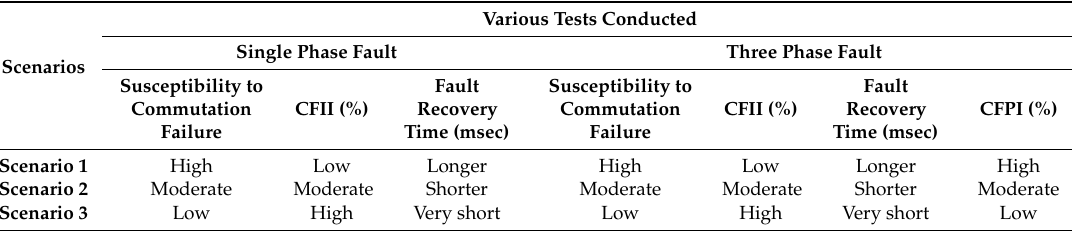
Figure 11. Active power of the UHVDC-HCS system with and without STATCOM coordinated control under three phase fault conditions: ( a ) HEC ( b ) LEC. Table 2. Summary of the Operating Characteristics of UHVDC-HCS System under Various Tests Conducted for three Scenarios.